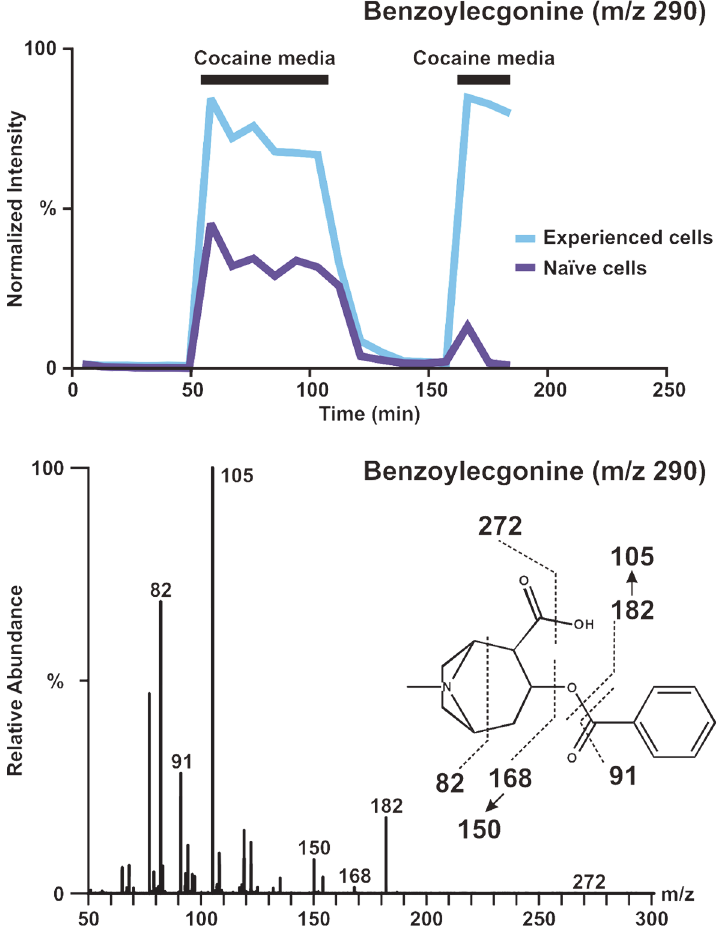
Fig 6. Benzoylecgonine (BE) time course and fragmentation data. Top: BE time course data for experienced (blue) and na ï ve (purple) cells. While data were gathered sequentially, plots are overlaid to highlight the increased abundance of BE in experienced cells. The absence of the expected increase in BE corresponding to step 4 (the last step of cocaine exposure) suggests a decrease in cocaine metabolism, possibly due to cell death. Bottom: The fragmentation spectra of BE are shown with parent ion of m/z 290.